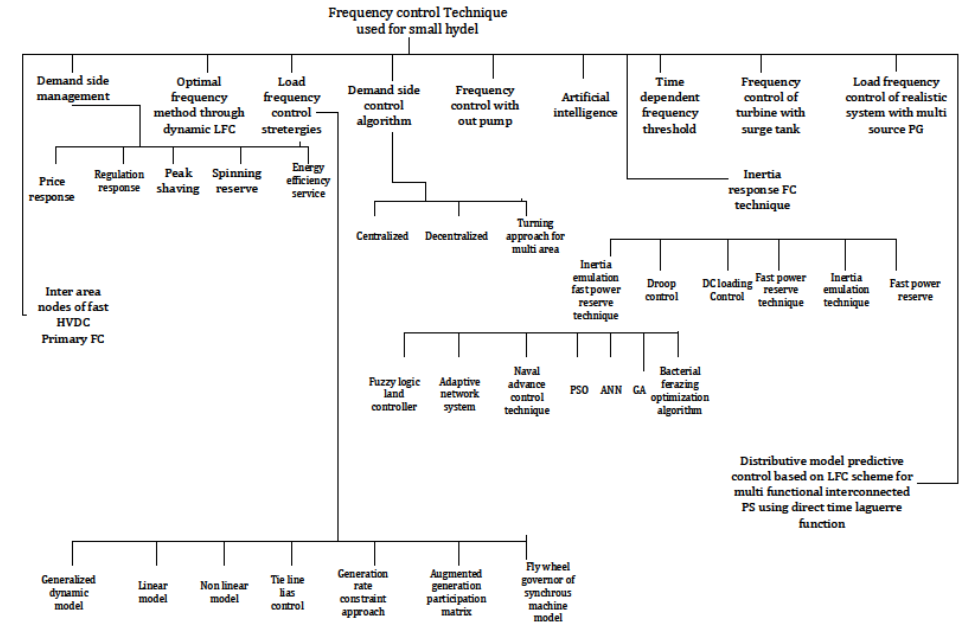
Fig. 1: The flow chart diagram of different frequency control techniques used for small hydel